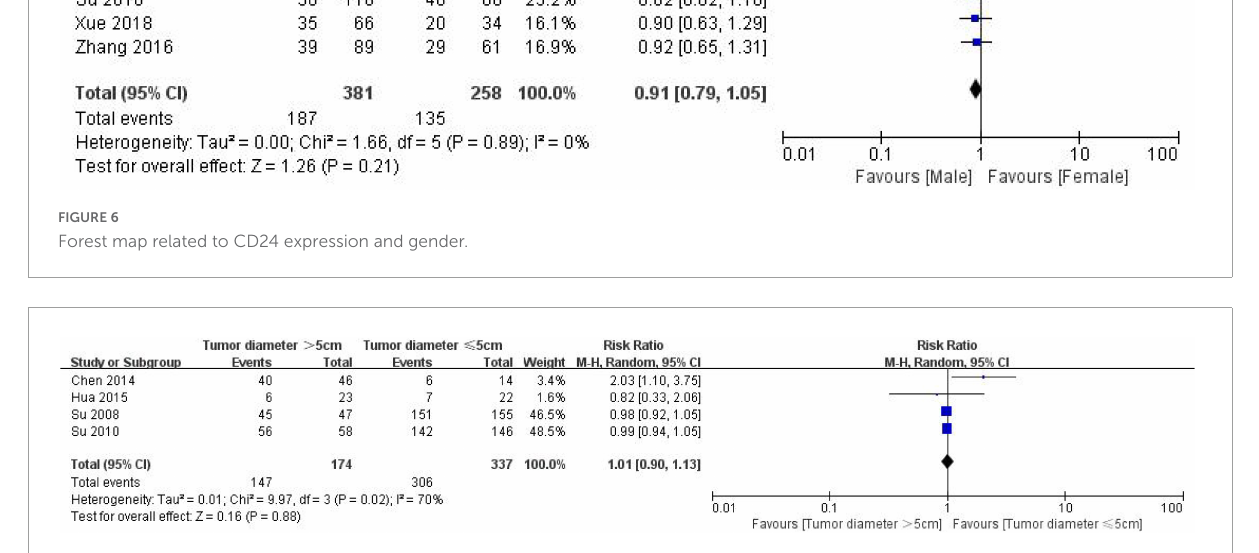
FIGURE7 Forest map related to CD24 expression and tumor diameter.